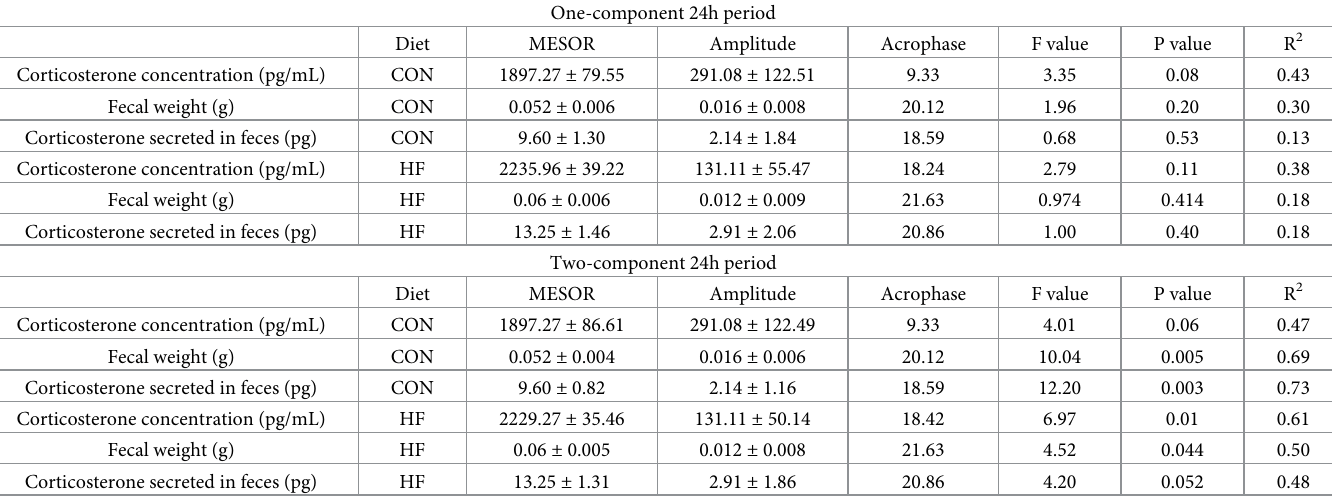
Table 2. One-component and two-component cosine fit analysis of fecal corticosterone concentration, fecal weight, and total corticosterone secreted in